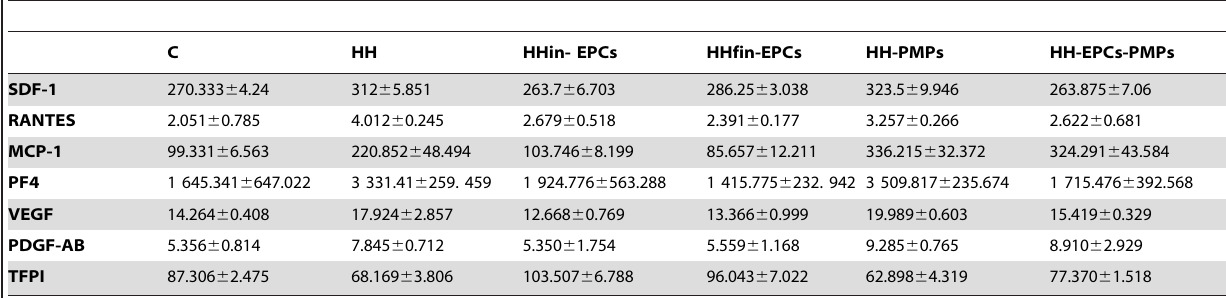
Table 2. Chemokine and factor release in platelet supernatants of investigated hamster groups (n=6 for all molecules; concentration expressed as pg/mL).